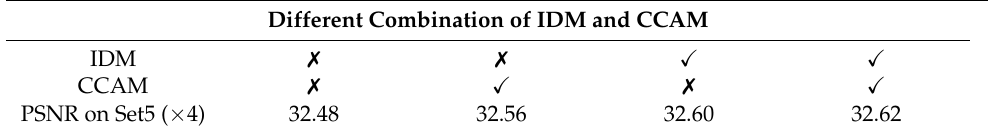
Figure 11. IMDN-Basic. The grey box represents multi-factor upscaling module. Table 4. Investigations of CCA module and IIC